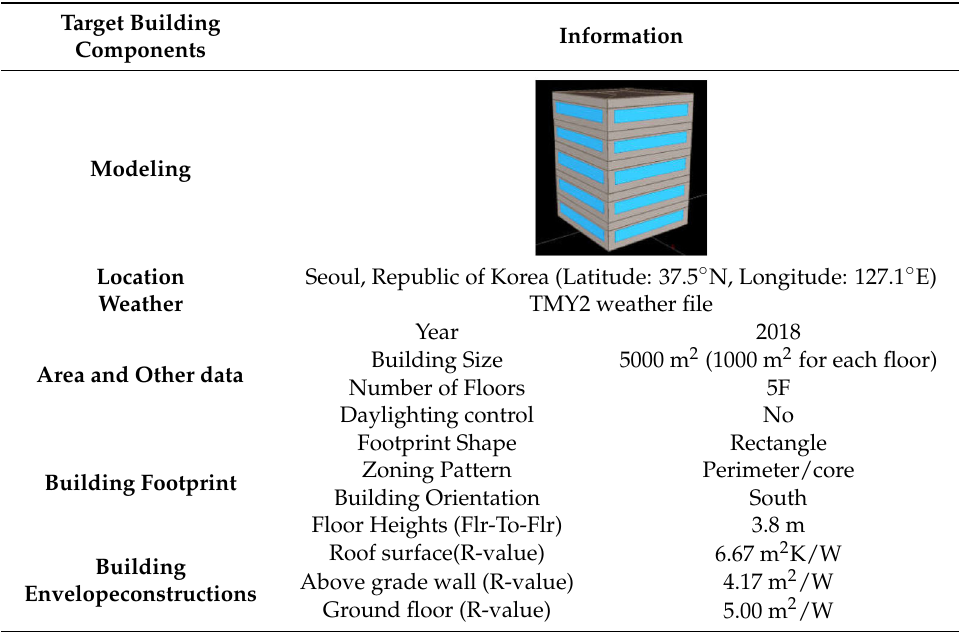
Table 2. Parameters of simulation